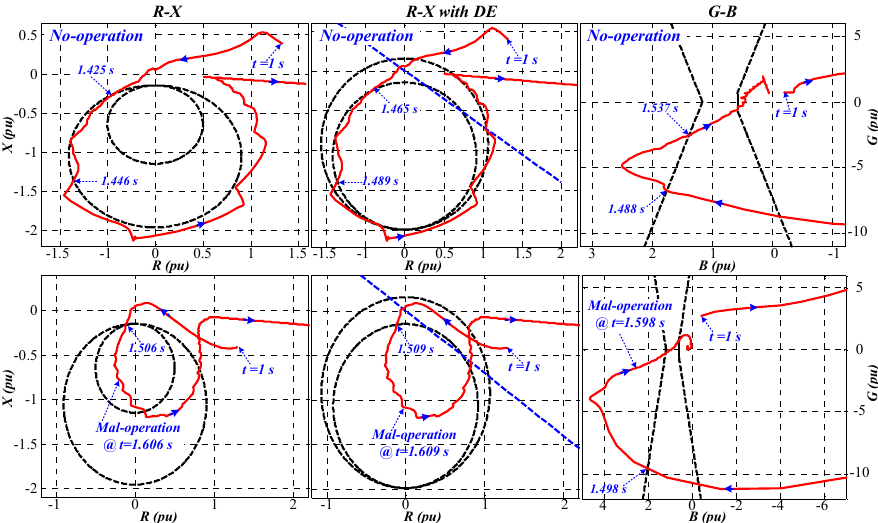
Figure 10. The behaviors of the traditional LOE detection schemes during first stable power swing (SPS) scenario (first row) and the second scenario (second row).